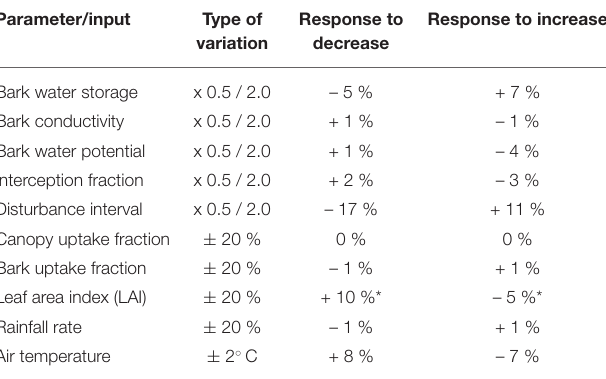
TABLE 3 | Change in the simulated NPP of NV epiphytes, compared to the control run, resulting from variation of model parameters or climate input data. Parameter/input Type of